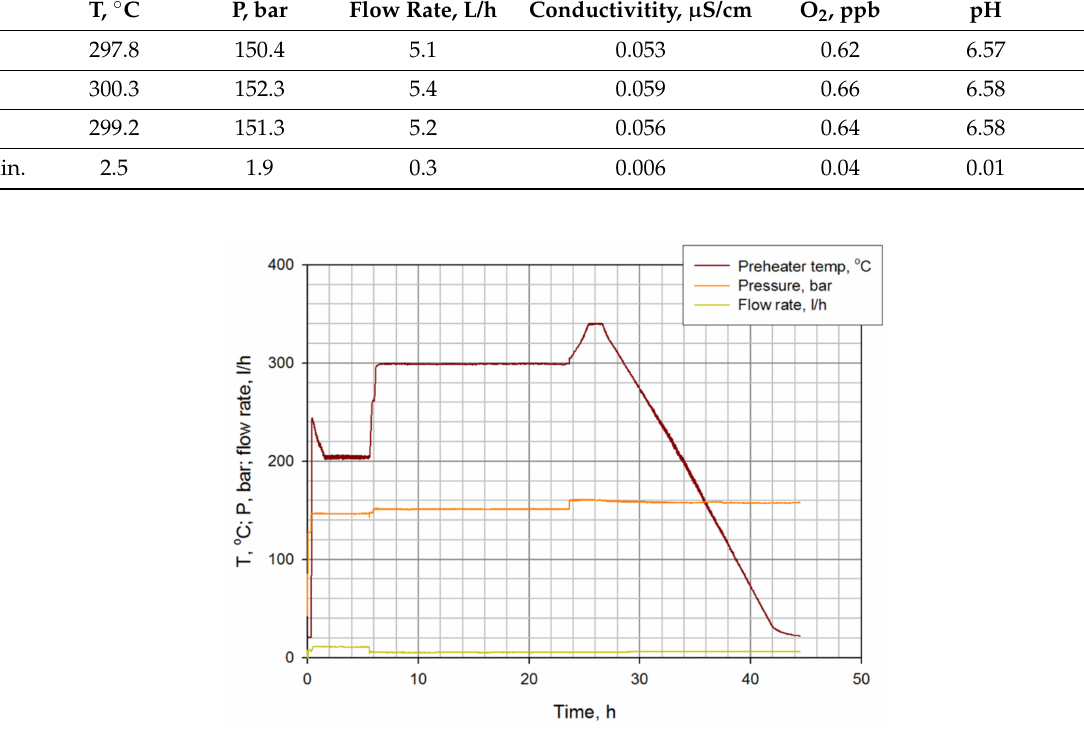
Figure 7. Preheater temperature, pressure, and flow rate during the first operational test of the recirculation loop.